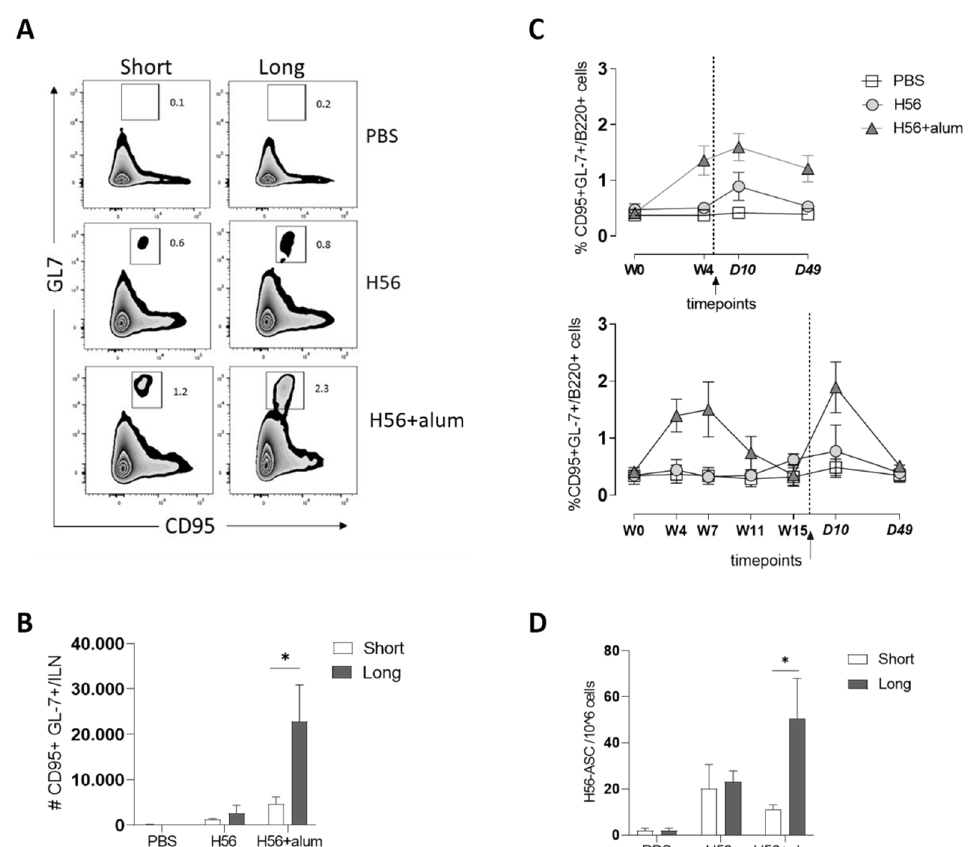
Figure 3. B-cell response. C57BL/6 mice were subcutaneously immunized, as summarized in Figure 1. ( A ) Germinal center B cells were identified as GL-7 + CD95+ among B220 + B cells in iliac lymph nodes 10 days after boosting. Dot plots are shown from a single animal representative of the group, and numbers indicate frequencies of CD95 + GL-7 + respect to B220 + cells B–C. Time-course analysis of the frequencies of GC- cells, with respect to B220+ B cells ( B ) and absolute numbers of GC-B cells per ILN ( C ) reported as mean ± SEM of six mice per group. ( D ) Number of H56-specific IgG-secreting cells per million splenocytes, reported as mean ± SEM of six mice per group. The Mann–Whitney test for multiple pairwise comparisons was used to assess the statistical difference between the short (4W) and long (18W) schedules for each vaccine formulation. * p ≤ 0.05.